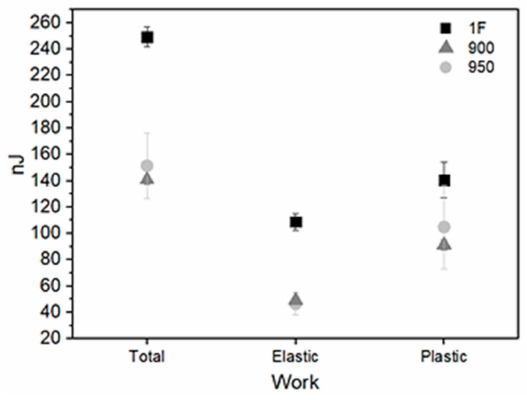
Figure 7. Total, elastic, and plastic